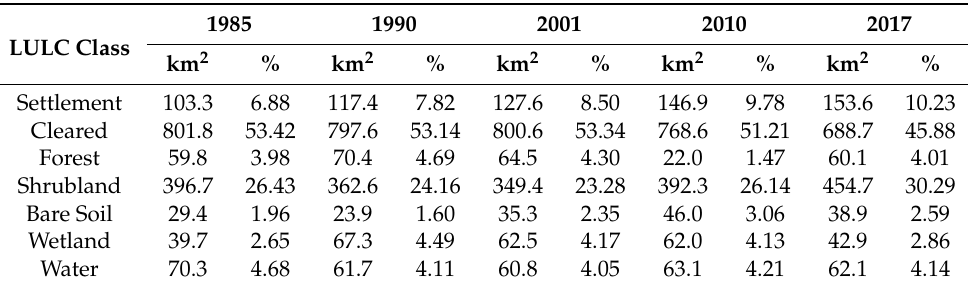
Figure 2. Ratio of land use and land cover classes in the hinterland of Barranquilla differentiated per landscape unit for the years 1985, 1990, 2001, 2010, and 2017. Table 5. Changes of area size per land use and land cover class in the hinterland of Barranquilla for the years 1985, 1990, 2001, 2010, and 2017 across all landscape